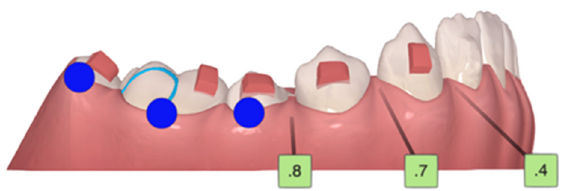
Figure 7. First AA, with tooth 45 microdontic. Blue dots—moderate movements. (with three advancement steps), with the last step planned in the edge-to-edge position.